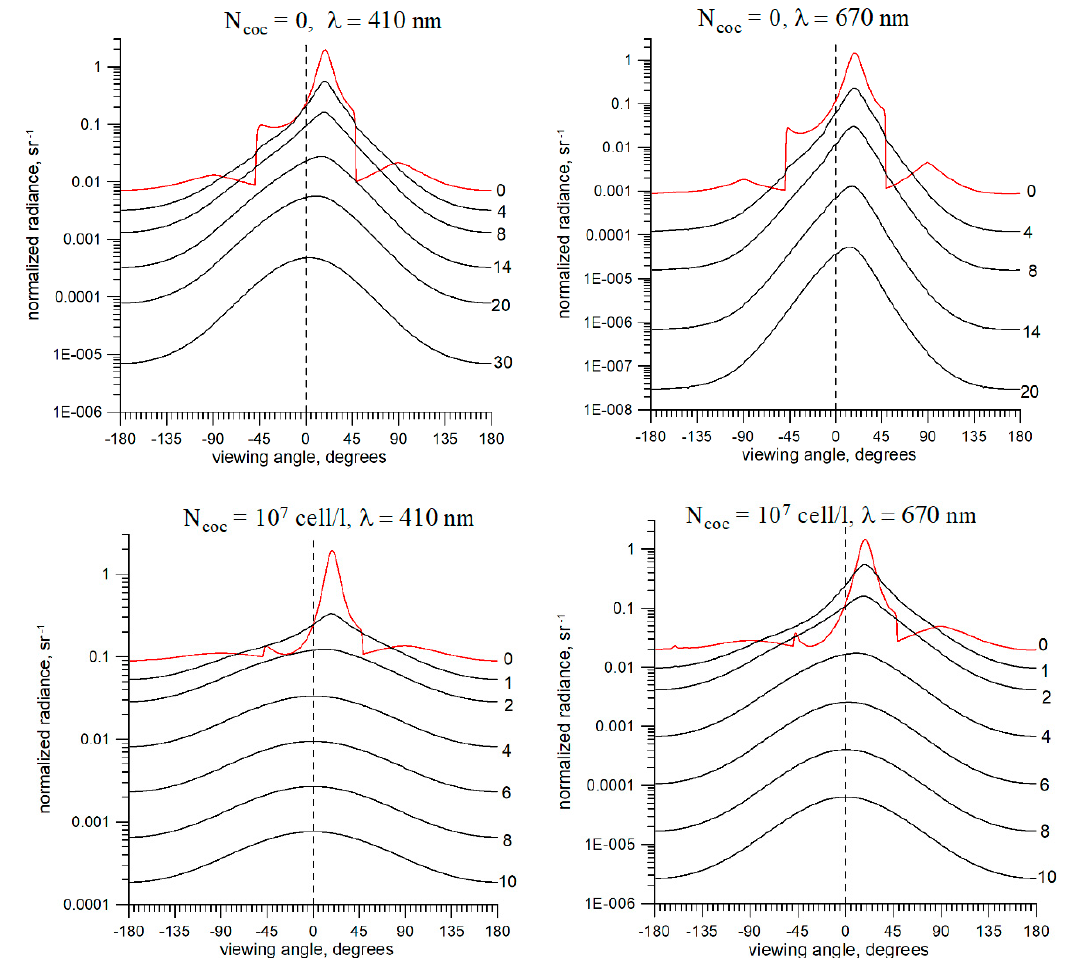
Figure 8. Black Sea. The angular radiance distributions at 410 and 670 nm; a (440) = 0.09 m − 1 , θ 0 = 25°, wind speed 0 m/s. All others are the same as in Figure 4.